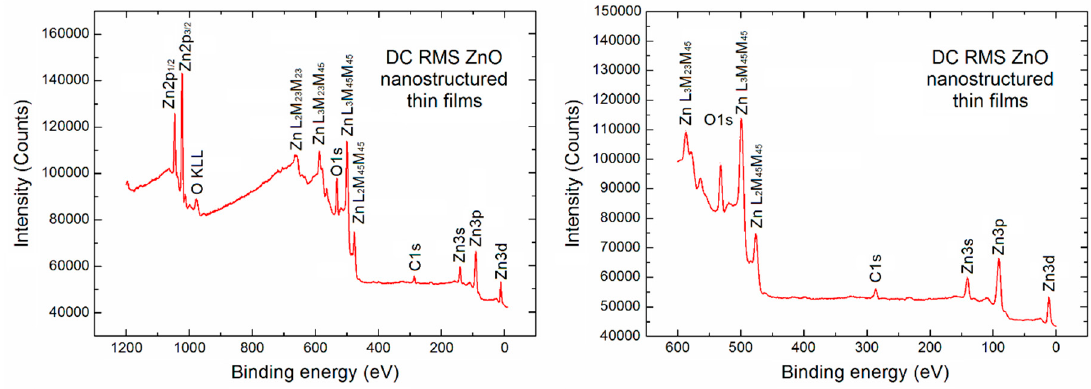
Figure 2. XPS survey spectra (full and in limited 600 eV BE range) of the ZnO nanostructured thin films used in our SPV gas sensor.